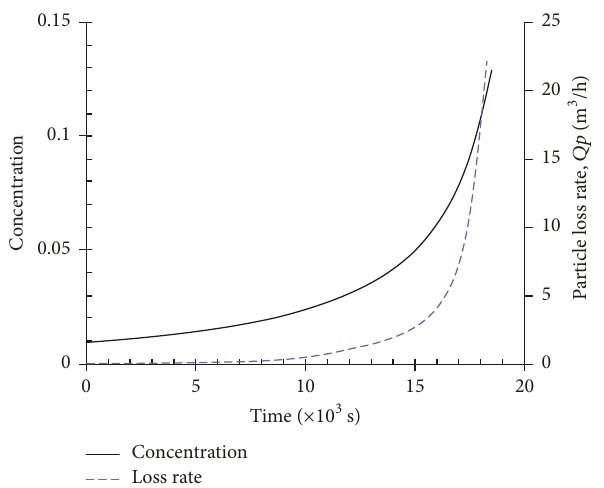
Concentration Loss Figure 22: Evolution of average particle volumetric concentration and particle loss rate.